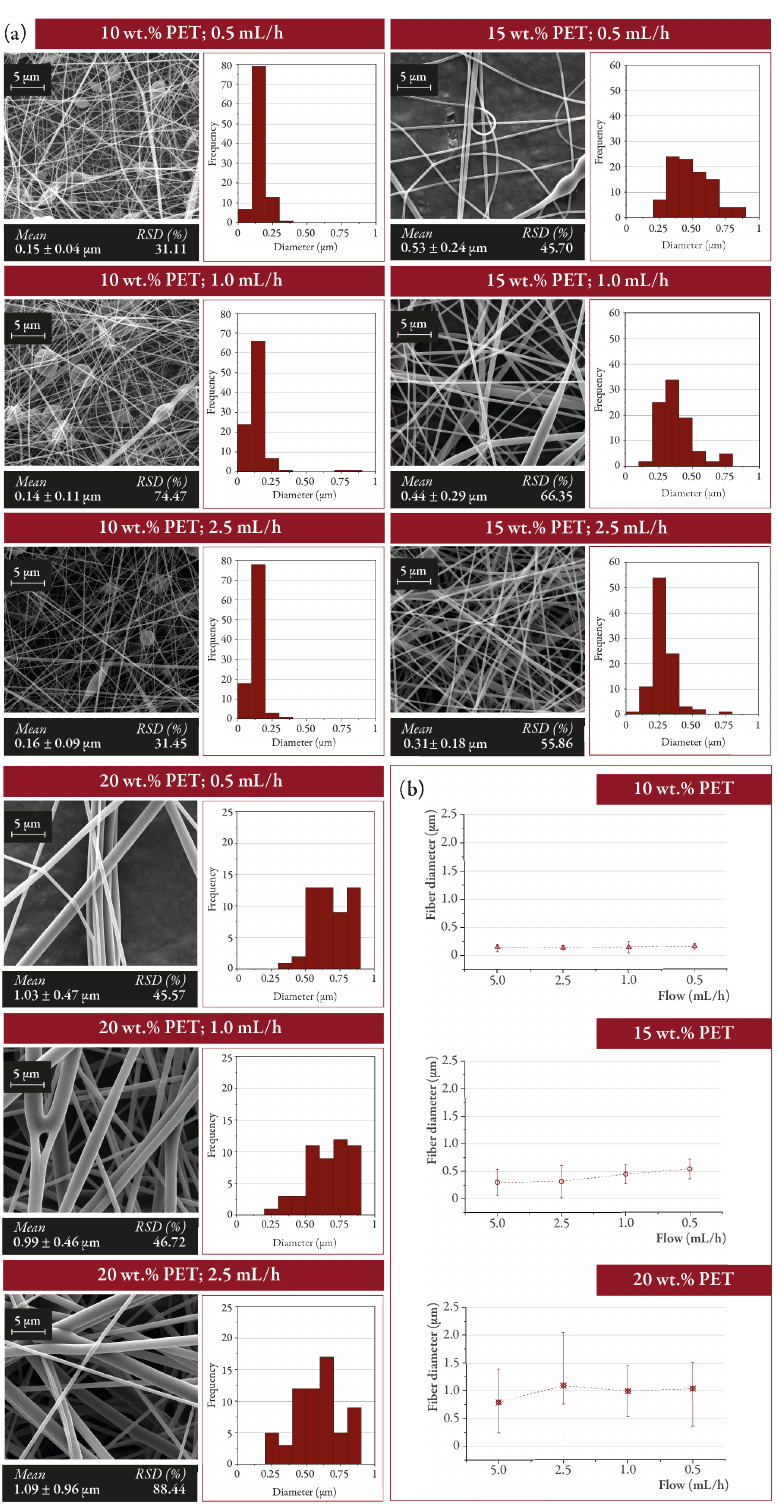
Figure 4. ( a ) Morphology of the electrospun fibers as a function of the polymer concentration (10, 15, and 20 wt.% PET) and the solution output flow (0.5, 1.0, 2.5, and 5.0 mL/h) and ( b ) variation of the diameter of electrospun fibers ( n = 100) depending on the output flow of the ejected